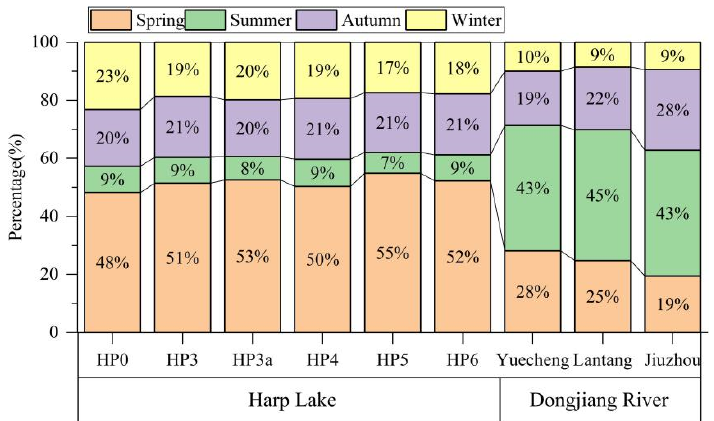
Figure 4. Ratio of seasonal streamflow to the total annual streamflow in the Harp Lake and Dongjiang River catchments.